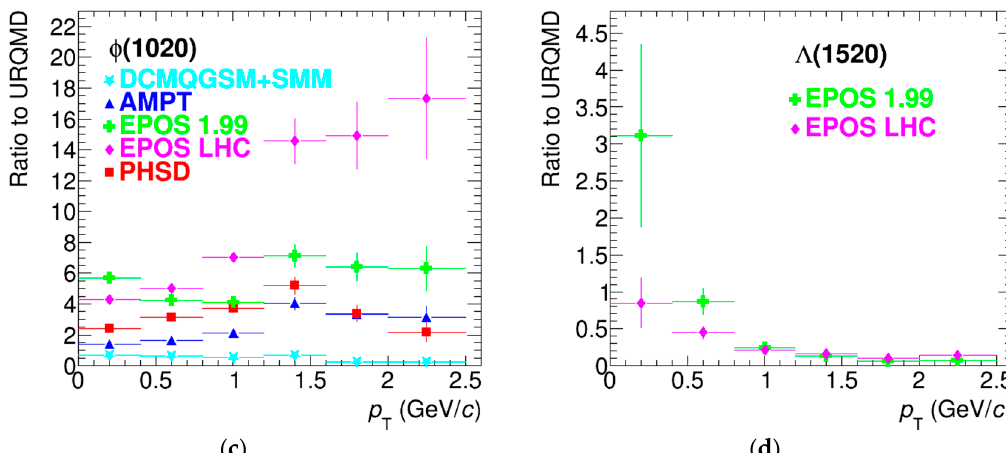
Figure 3. Ratios of p T -differential yields predicted for ρ (770) 0 ( a ), K*(892) 0 ( b ), φ (1020) (c) and Λ (1520) ( d ) resonances by different event generators in Au+Au collisions at √ s NN = 9 GeV to the UrQMD [11] predictions. Statistical uncertainties are shown with error bars. Systematic uncertainties are ~5% and are not shown for better visibility.